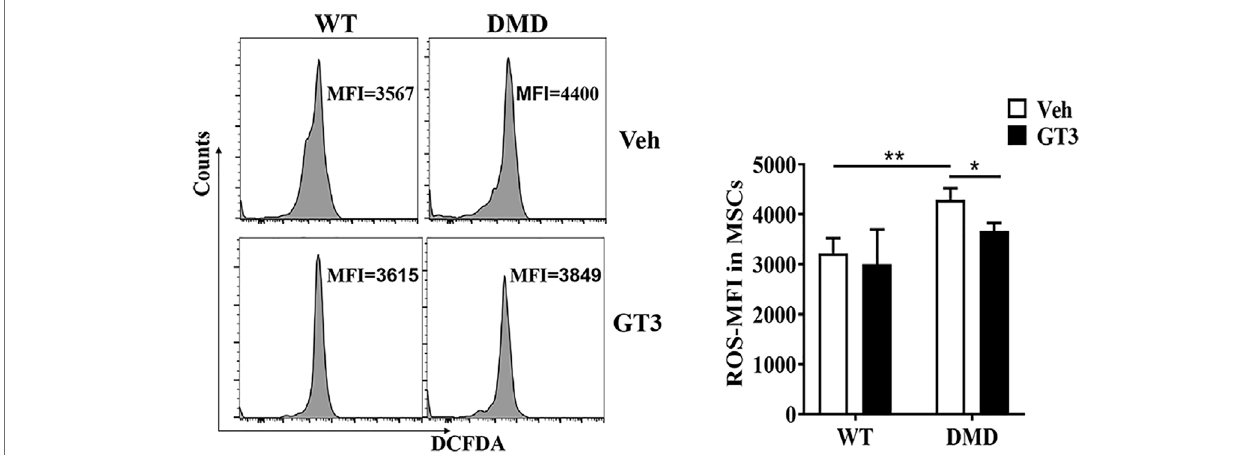
FIGURE11| OxidativefreeradicallevelsinDMDmiceandWTmice.DCFDAprobewasusedtodetectoxidativefreeradicalinWTandDMDmiceby fl owcytometry (left panel). Mean fl uorescence intensity (MFI) of DCFDA in muscle stem cells were demonstrated. Data were presented at means ± SEM ( n = 6) with two-way ANOVA analysis. * p < 0.05, ** p <